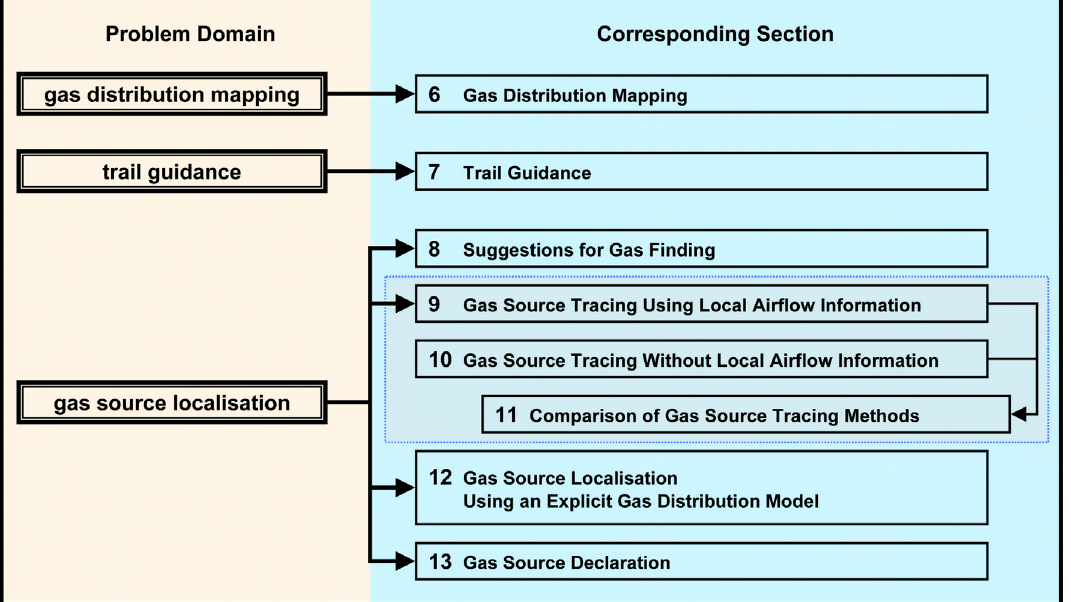
Figure 4 . Subdivision of the work on airborne chemical sensing with mobile robots used to structure the literature review in this article. The different problem domains addressed are shown on the left side, and the corresponding sections, including the section numbers, are given on the right